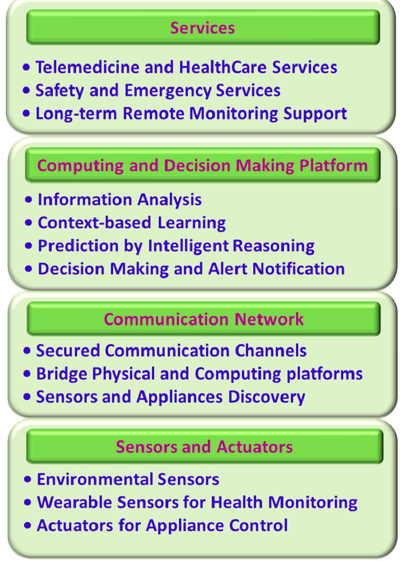
Figure 4. A four layer architecture for smart home.